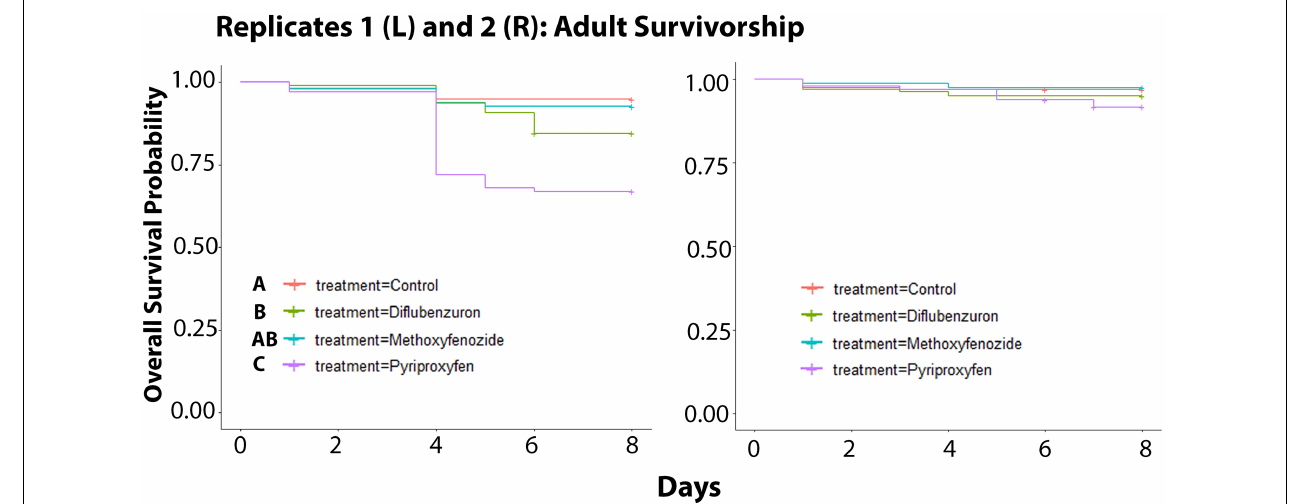
FIGURE 3 | Survivorship of adult Apis mellifera workers following developmental exposure to IGDs for Replicates 1 (Kaplan Meier Survival Analysis, χ 2 = 38.5, df = 3, p ≤ 0.0001) and 2 ( χ 2 = 3.9, df = 3, p = 0.3). Significance indicated by letters.